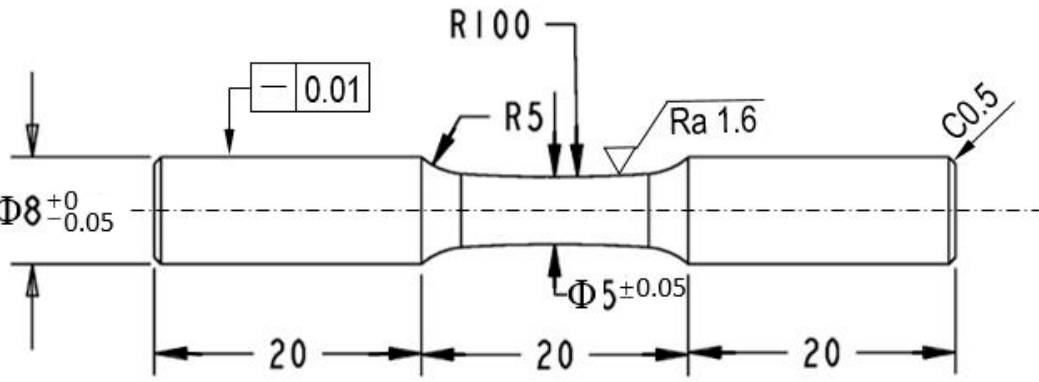
Figure 1. Geometrical dimensions and surface characteristics of the fatigue specimen.